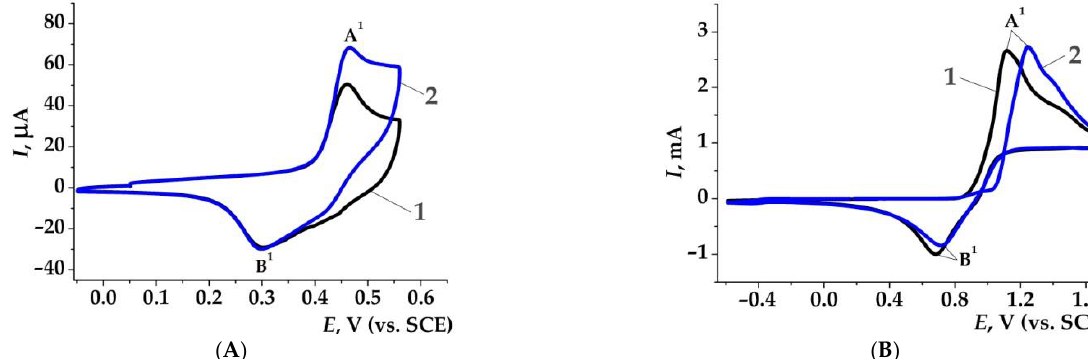
Figure 3. CV curves, ν = 0 .10 V ‧ s −1 . ( A ) On Ni working electrode in 0.2M aq. NaOH: electrogenerated Ni(OH) 2 — 1; after addition of 1-methyl-1 H -pyrazol-3-amine 1k (0.002M) — 2; ( B ) on Pt working electrode in 1M aq. NaNO 3 : NaBr (0.3M) — 1; after addition of 1-methyl-1 H -pyrazol-3-amine 1k (0.002M) — 2.